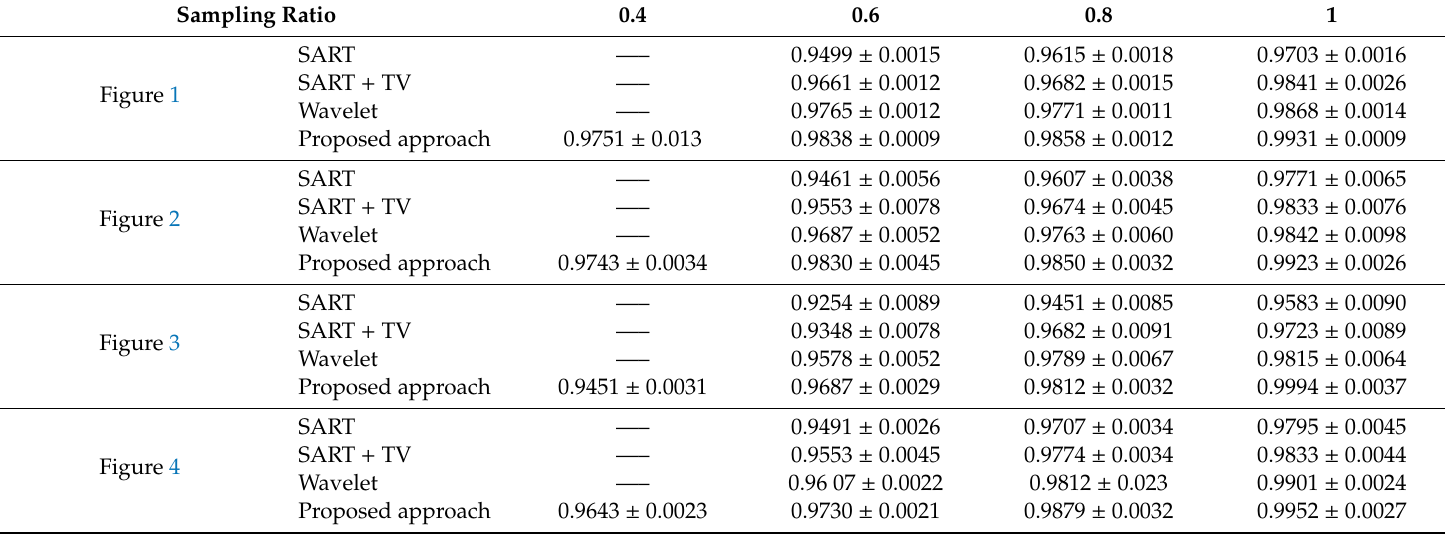
Table 3. Structural similarity index metric (SSIM) average performance comparison of the proposed algorithm with a series of algorithms, namely, SART [3], SART + TV [13], Patch + ordering Wavelet